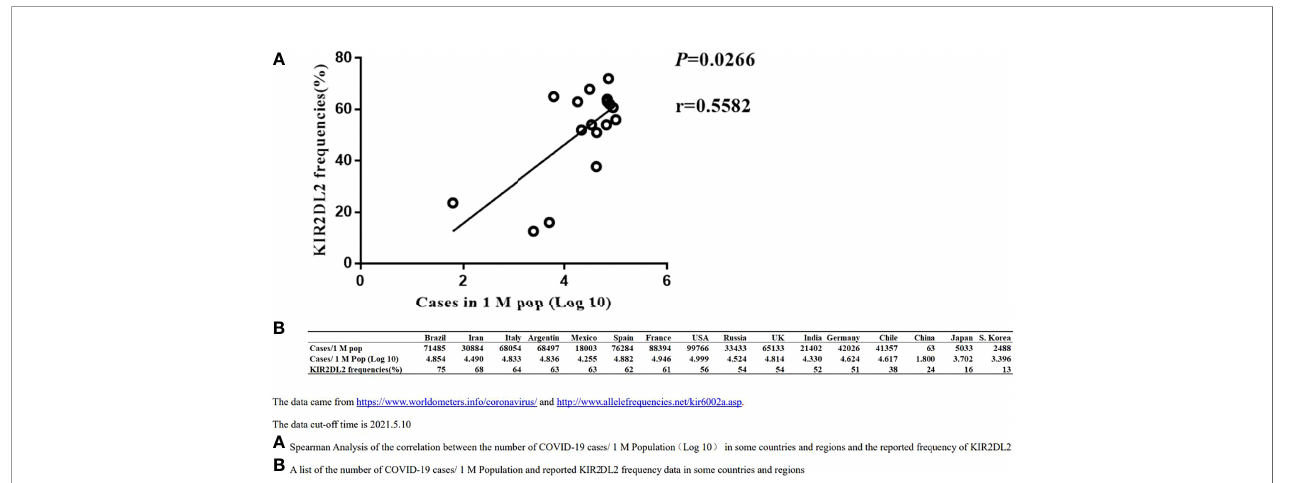
FIGURE 1 | Spearman Correlation analysis between the distribution of KIR2DL2 and the occurrences of global COVID-19 cases. The data cut-off time is 2021.5.10. (A) . Spearman Analysis of the correlation between the number of COVID-19 cases/1 M Population(Log 10) in some countries and regions and the reported frequency of KIR2DL2. (B) . A list of the number of COVID-19 cases/1 M Population and reported KIR2DL2 frequency data in some countries and regions.